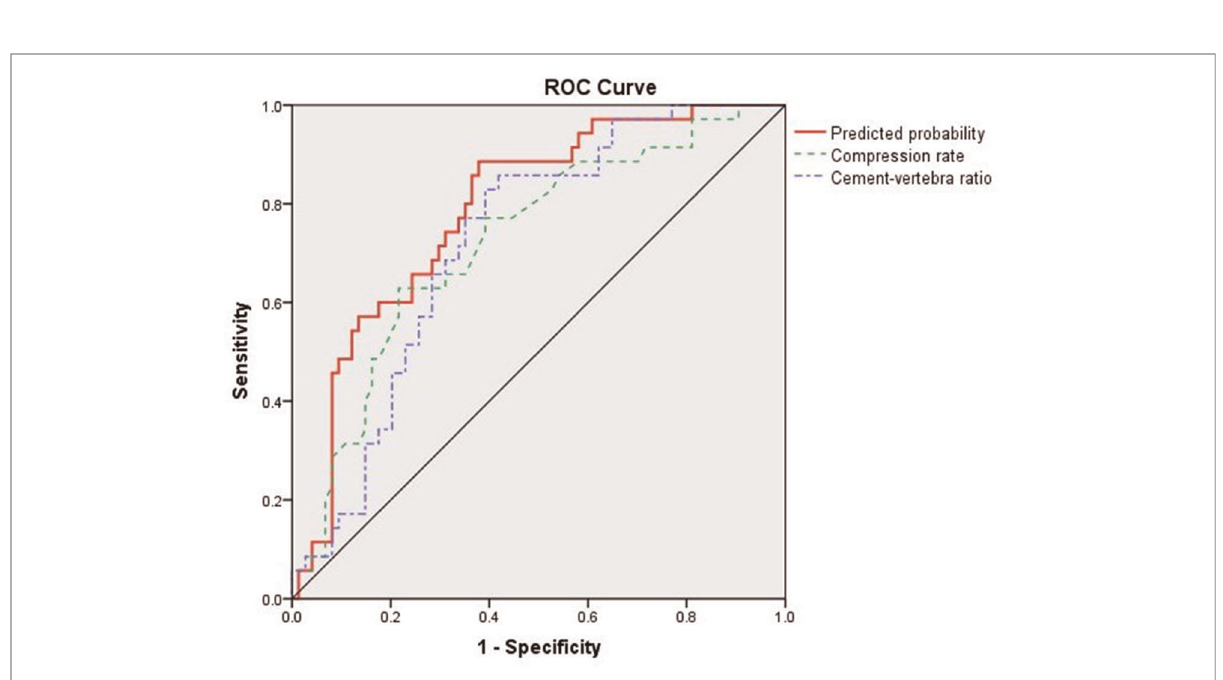
FIGURE 3 Receiver operating characteristic (ROC) curve of compression rate, cemented vertebral body fraction, and overall predicted probability, C-statistic=